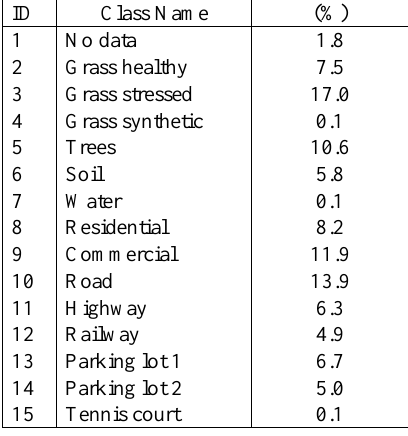
Table 1. Ground truth classes and the number of pixels selected shadowed